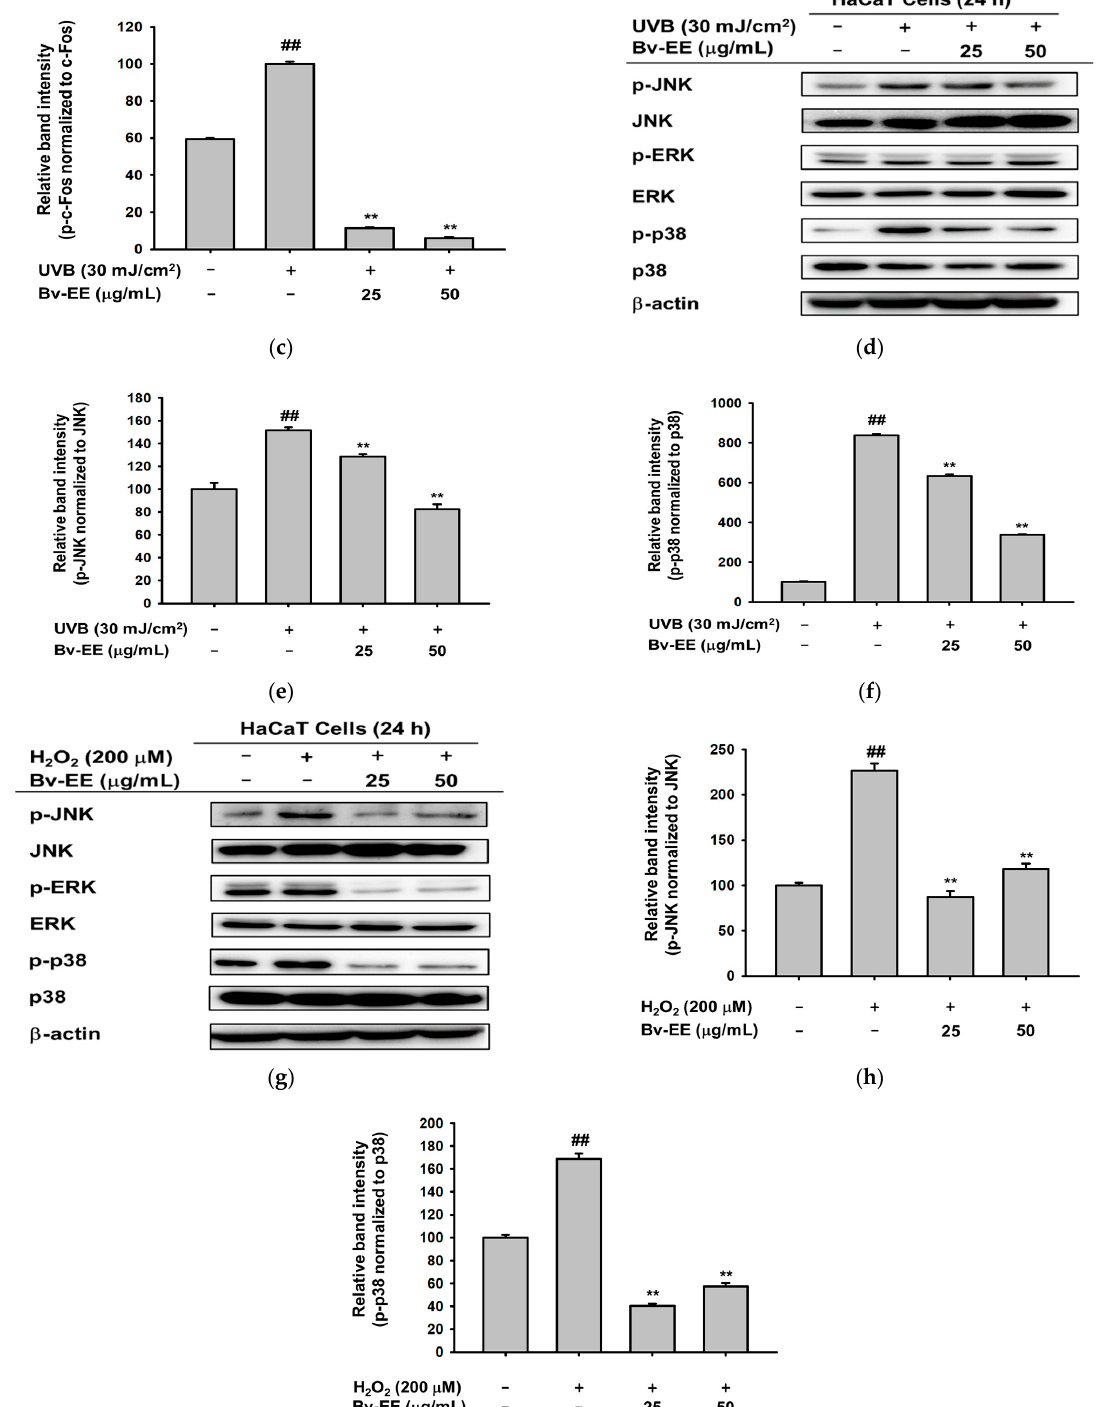
Figure 5. Bv-EE inhibits the AP-1 signaling pathway. ( a ) HaCaT cells were incubated with Bv-EE and irradiated with UVB for 24 h. Then, the phosphorylated protein levels of c-Jun and c-Fos were examined by Western blot. ( d , g ) The phosphorylation of ERK, JNK, and p38 was determined by Western blotting following Bv-EE treatment and exposure to UVB or H 2 O 2 . β -actin was used as an internal control ( b , c , e , f , h , i ) Band intensity was measured and quantified using ImageJ. All results are expressed as means ± standard deviations. ## p < 0.01 compared with the positive control group, and ** p < 0.01 compared with the normal